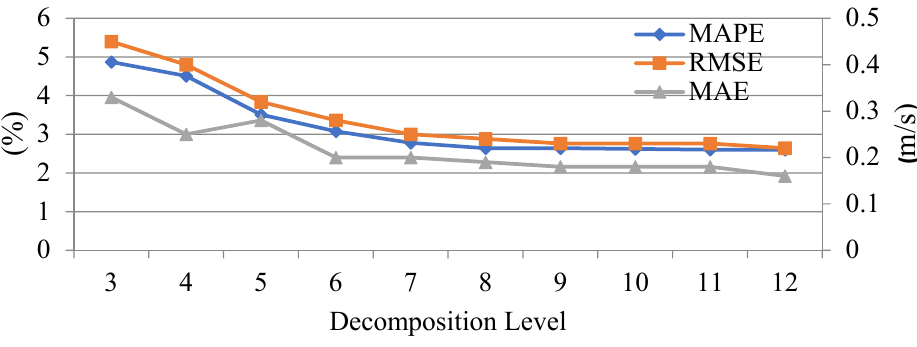
Figure 19. Prediction results at different decomposition levels.